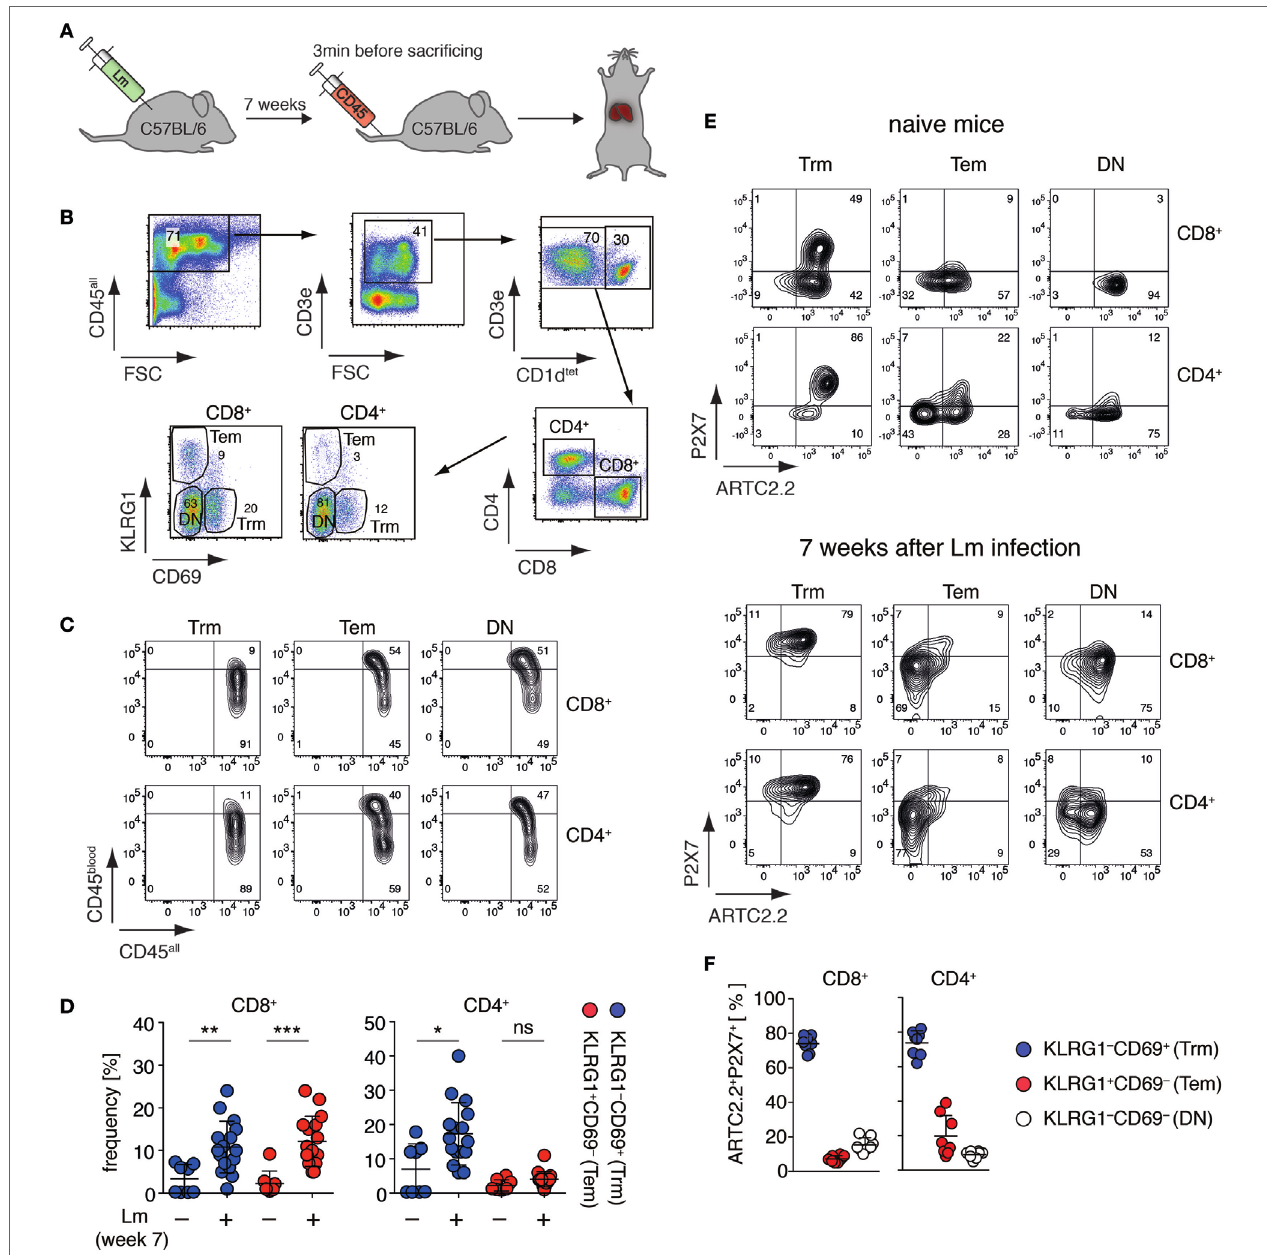
FIgURe 1 | Liver Trm co-express high levels of ARTC2.2 and P2X7. (A) C57BL/6 mice were infected i.v. with 2 × 10 4 Listeria monocytogenes (Lm). Seven weeks after infection, mice were treated with perCP-labeled anti-CD45 3 min before sacrificing to label vascular leukocytes. The liver of treated mice was harvested for Trm analyses. (B) Gating strategy: within the CD3 + CD1d tet − T cell pool Trm were identified as CD8 + CD69 + KLRG1 − or CD4 + CD69 + KLRG1 − and effector memory T cells (Tem) as CD8 + CD69 − KLRG1 + or CD4 + CD69 − KLRG1 + ; double negative (DN) marks CD8 + or CD4 + T cells that were CD69 − KLRG1 − . (C) In vivo anti-CD45 labeling (CD45 blood ) of Trm, Tem, and DN in relation to ex vivo anti-CD45 labeling (CD45 all ). (d) Frequencies of CD8 + and CD4 + Trm and Tem in the liver of naïve and Lm infected mice. Two groups were compared using Student’s t -test ( n = 8–16) with * p < 0.05, ** p < 0.01, *** p < 0.001. (e) FACS analyses of ARTC2.2 and P2X7 expression on Trm, Tem, and DN cells from naïve mice (upper panel) and mice 7 weeks after infection with Lm (lower panel). (F) Frequency of ARTC2.2 and P2X7 co-expressing cells from mice 7 weeks after Lm infection are quantified as % of CD4 + or CD8 + T cells. The shown data represent results from at least two independently performed